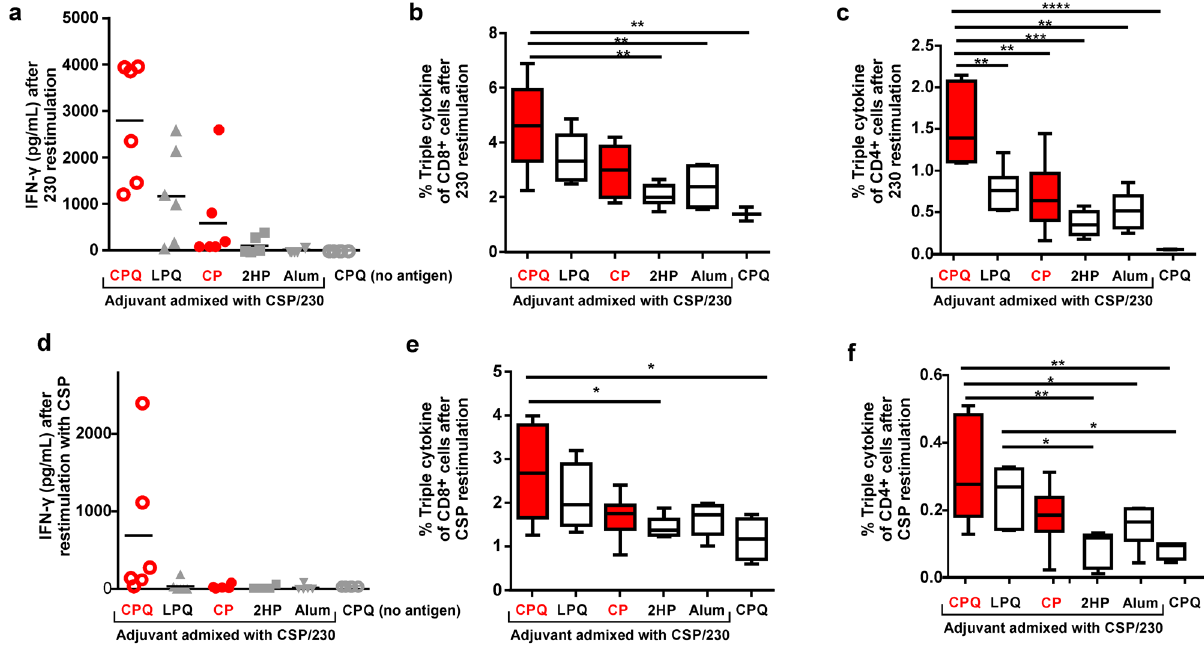
Fig. 6 Cellular responses. C57BL/6 mice ( n = 6 per group) were immunized in the same manner as in Fig. 5, and on day 42, splenocytes were isolated and restimulated with 1 µ g/ml CSP or 230. 230-speci fi c cellular responses are shown with respect to ( a ) IFN- γ secretion, and IL2 + TNFa + IFN- γ + triple positive CD8 + ( b ) and CD4 + ( c ) T cells. CSP-speci fi c cellular responses are shown with respect to ( d ) IFN- γ secretion, and IL2 + TNFa + IFN- γ + triple positive CD8